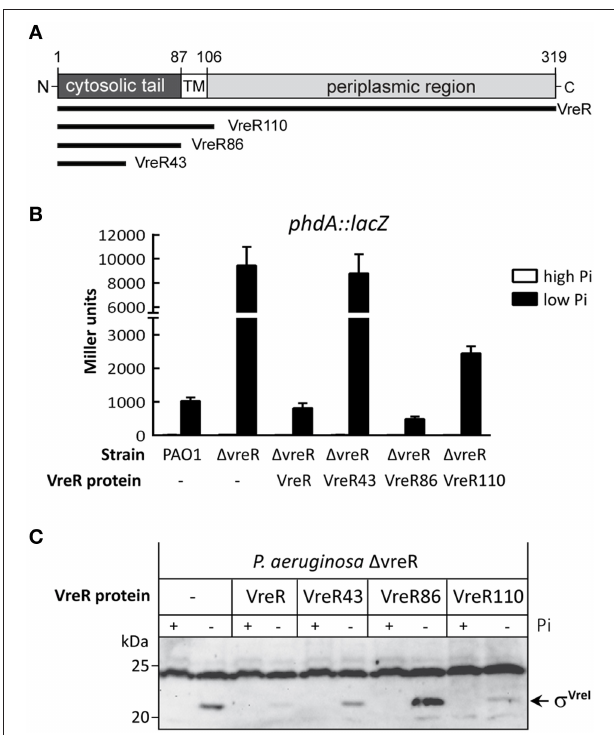
FIGURE 2 | Effect of the N-tail of VreR on σ VreI activity. (A) Schematic representation of the P. aeruginosa VreR protein. The VreR protein has been drawn to scale, and the cytosolic, transmembrane (TM), and periplasmic regions of the protein are shown. Numbers indicate amino acid positions. The produced VreR fragments are shown below the scheme. (B) β -galactosidase activity of the indicated P. aeruginosa strains bearing the transcriptional fusion phdA :: lacZ and the pMMB67EH (-), pMMB-VreR, pMMB-VreR43, pMMB-VreR86 or pMMB-VreR110 plasmid expressing the indicated VreR fragment from the IPTG-inducible promoter P tac ( Table 1 ). Strains were grown in high or low Pi in the presence of 1mM IPTG. (C) Detection of σ VreI in P. aeruginosa 1 vreR mutant upon expression of the indicated VreR fragment in high ( + ) or low ( − ) Pi and 1mM IPTG. Proteins were detected by Western-blot using a polyclonal anti-VreI antibody. The positions of the molecular size marker (in kDa) and the σ VreI protein are